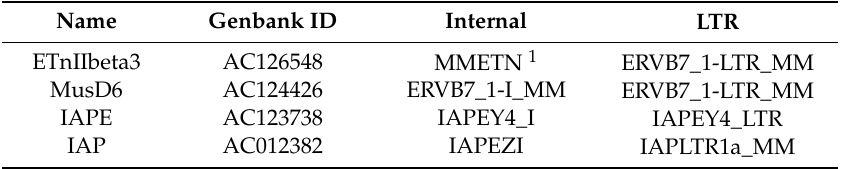
Table 1. ERV sequences used in this study to compare PBS sequences and phylogenetic relationships.